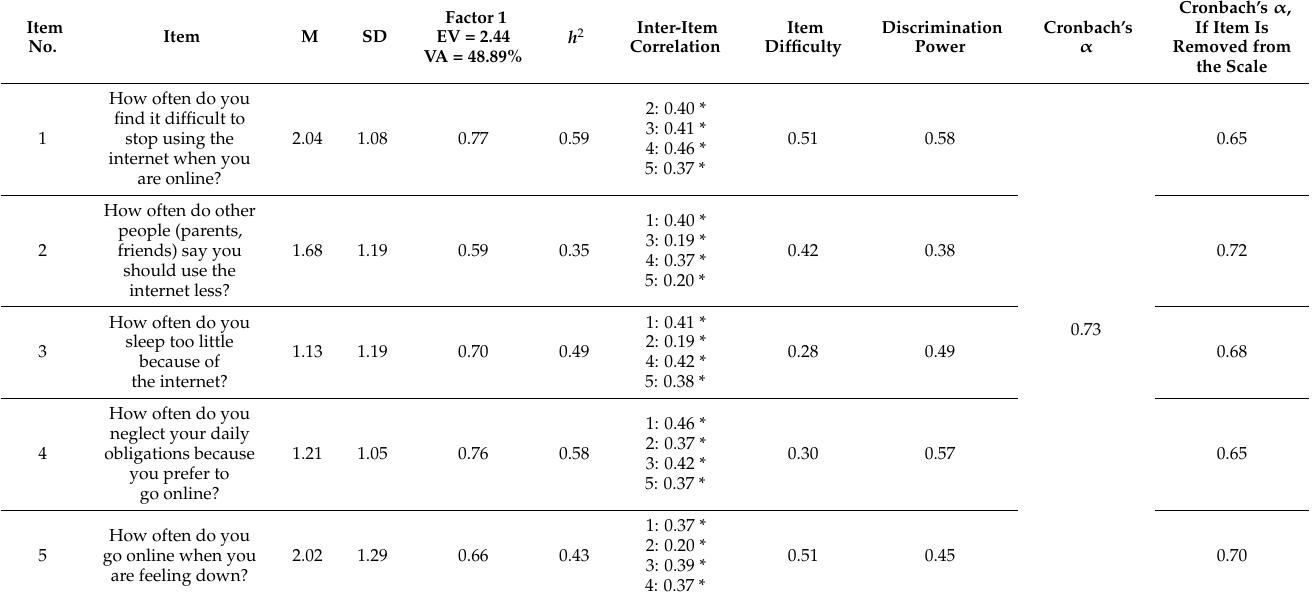
Table 1. Item analysis statistics and results of explanatory factor analysis of SCIUS ( n =